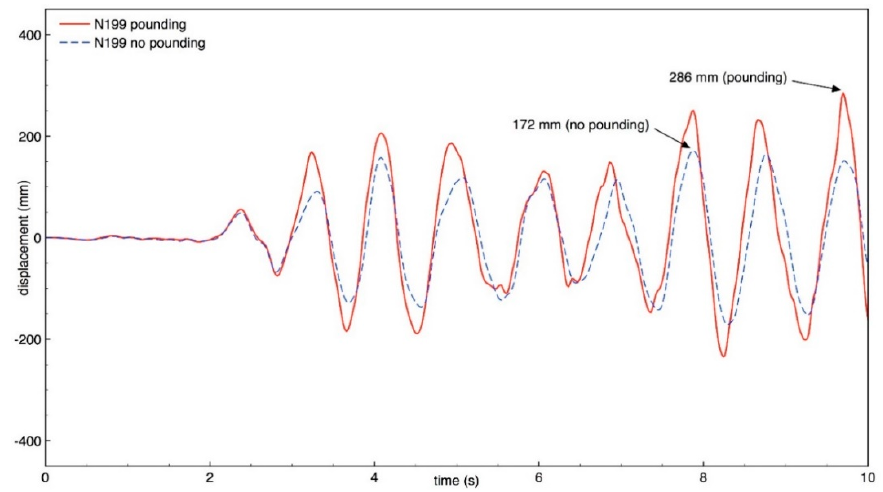
Figure 13. Longitudinal response of building A (node N199) with and without pounding.